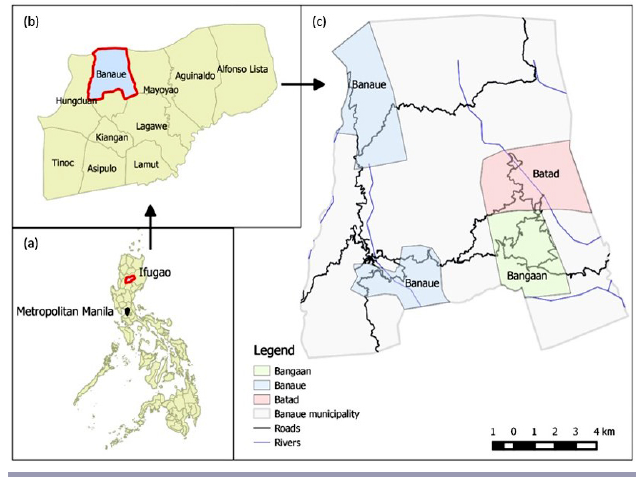
Fig. 3 . Study location in the municipality of Banaue (b), Ifugao Province, Philippines (a). Along with the Barangays of Bangaan and Batad, two separate areas within the town of Banaue (blue) were surveyed (c).